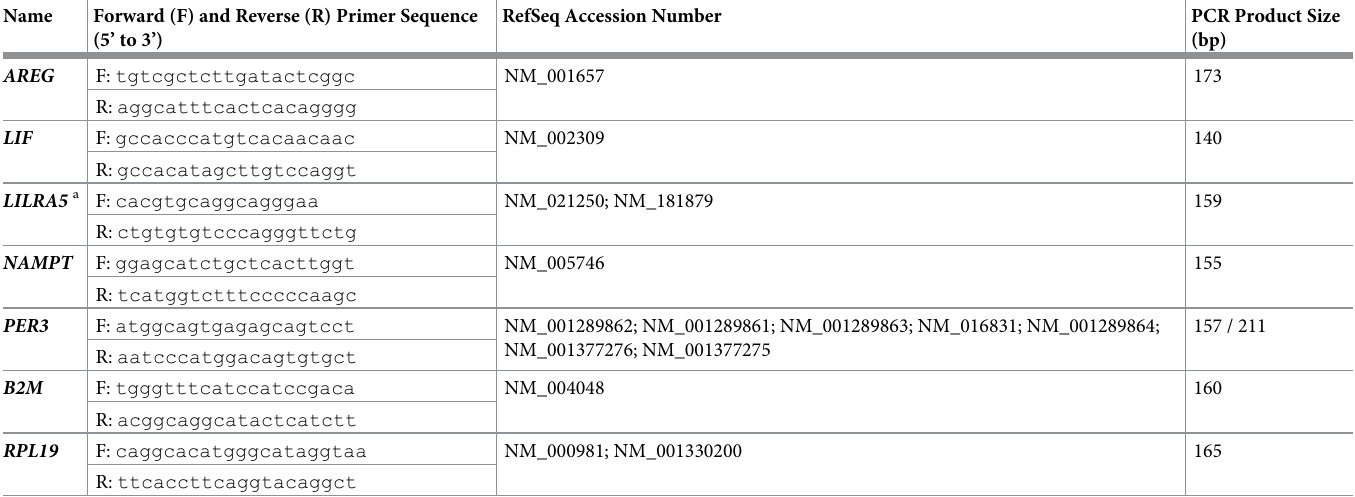
Table 1. Primers for